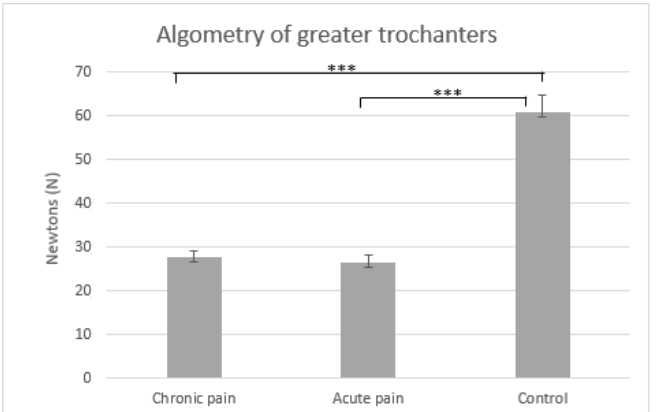
Figure 2. Means and typical errors of pressure pain thresholds (in Newtons) averaged for greater trochanters in the three groups (chronic pain vs. acute pain vs. control). *** p < 0.001.